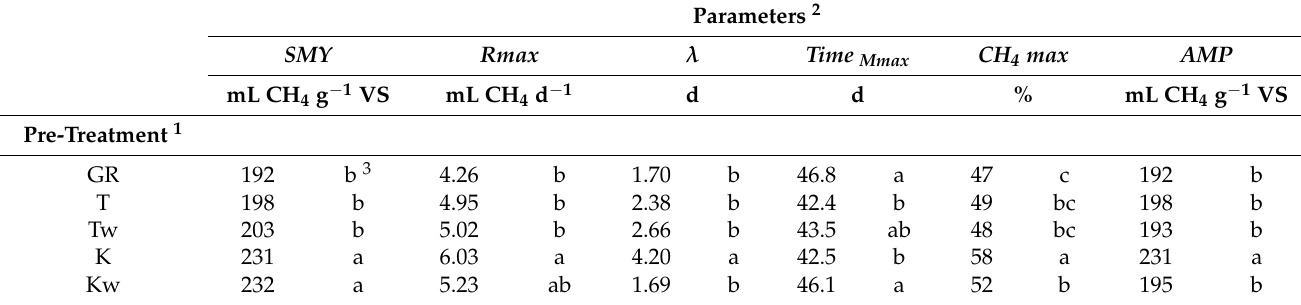
Figure 2. Measurements (points) and estimates (dashed curves) of the cumulative CH 4 production from giant reed during anaerobic digestion. Circles: KOH-based pre-treatments; squares: thermal pre-treatments; triangles: untreated giant reed. Empty symbols: washed samples; solid symbols: unwashed samples. Vertical bars represent the standard deviation of the mean ( n = 3). Table 4. Anaerobic digestion parameters of the differently pre-treated giant reed